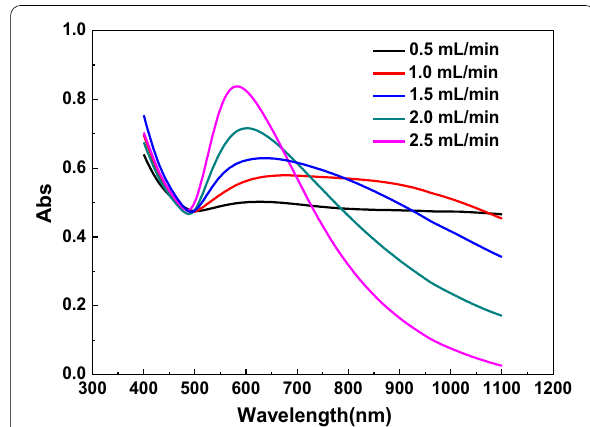
Fig. 1 UV–Vis spectra of GNPs prepared with the feeding rate of 0.5,